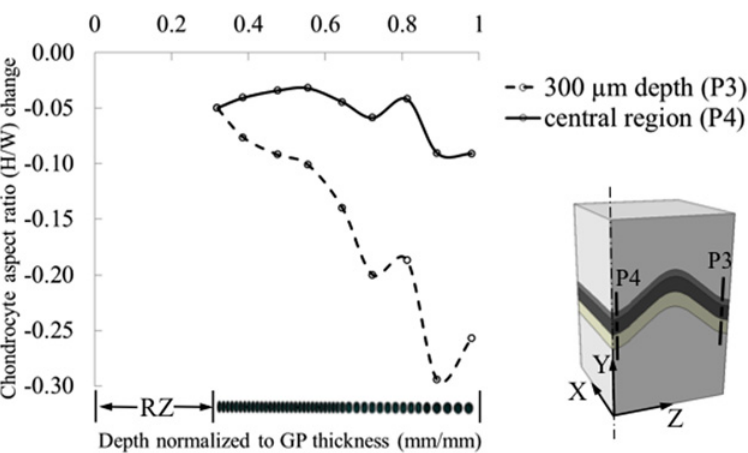
Fig 9. Chondrocyte aspect ratio change with deformation at the center and 300 μ m away from the edge. Aspect ratio is defined as the ratio of the height over the width of the